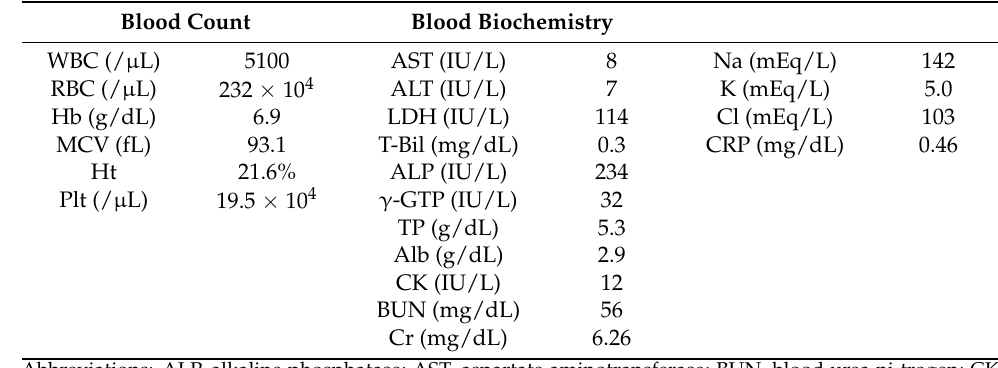
Table 1. Blood test findings on